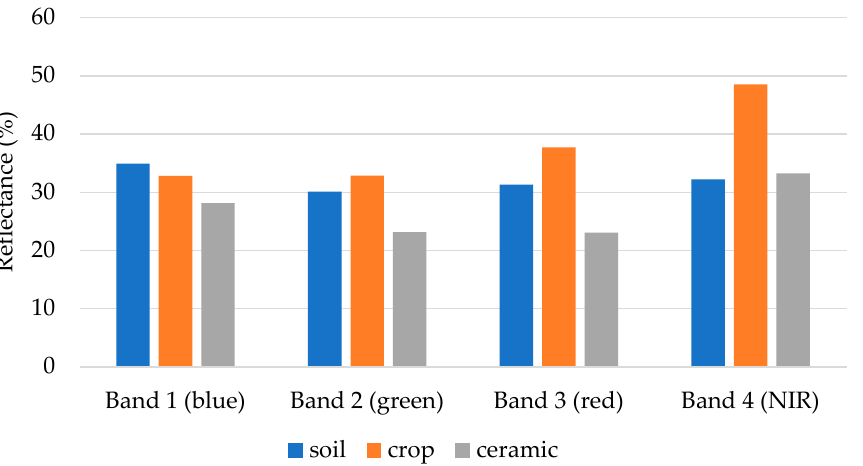
Figure 10. Reflectance values (in %) for three main classes of Area 6: background soil, crops, and ceramics, for the visible (blue–green–red) and near-infrared part of the spectrum.